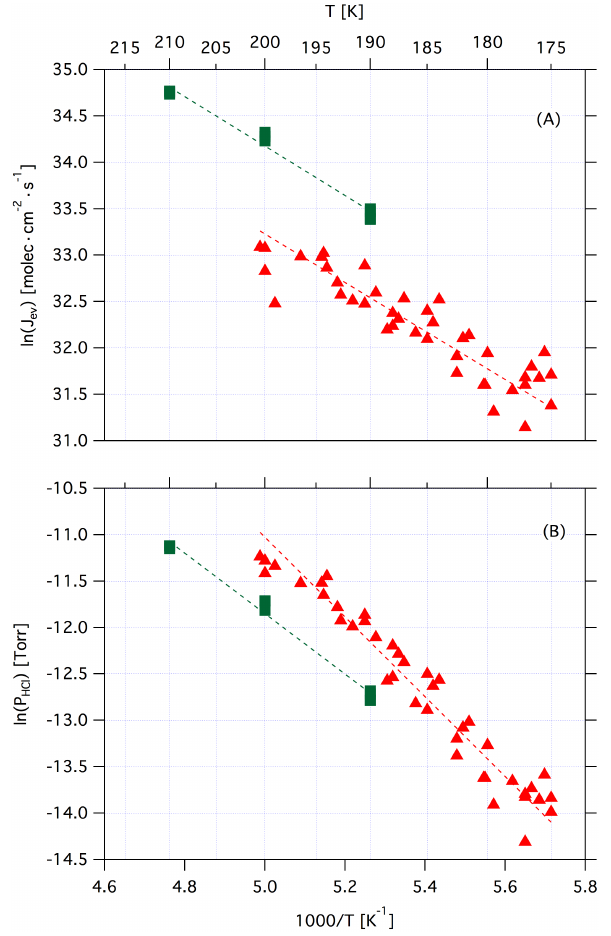
Figure 13: Arrhenius plot of J ev (HCl) (Panel A) and van‘t Hoff plot of P eq (HCl) 1278 Figure 13. Arrhenius plot of J ev (HCl) (A) and van’t Hoff plot of P eq (HCl) (B) . Red triangles represent the results for the interaction (Panel B). Red triangles represent the results for the interaction of HCl with 1279 of HCl with amHCl/H 2 O down to T=175K (this study) and green amHCl/H 2 O down to T = 175 K (this study) and green squares the results from a 1280 squares the results from a Knudsen flow reactor study addressing Knudsen flow reactor study addressing the HCl/H 2 O liquid-ice coexistence region 1281 the HCl/H 2 O liquid–ice coexistence region (Flückiger et al., 1998). (Flückiger et al., 1998). The equations for the fitting lines may be found in the text. 1282 The equations for the fitting lines may be found in the